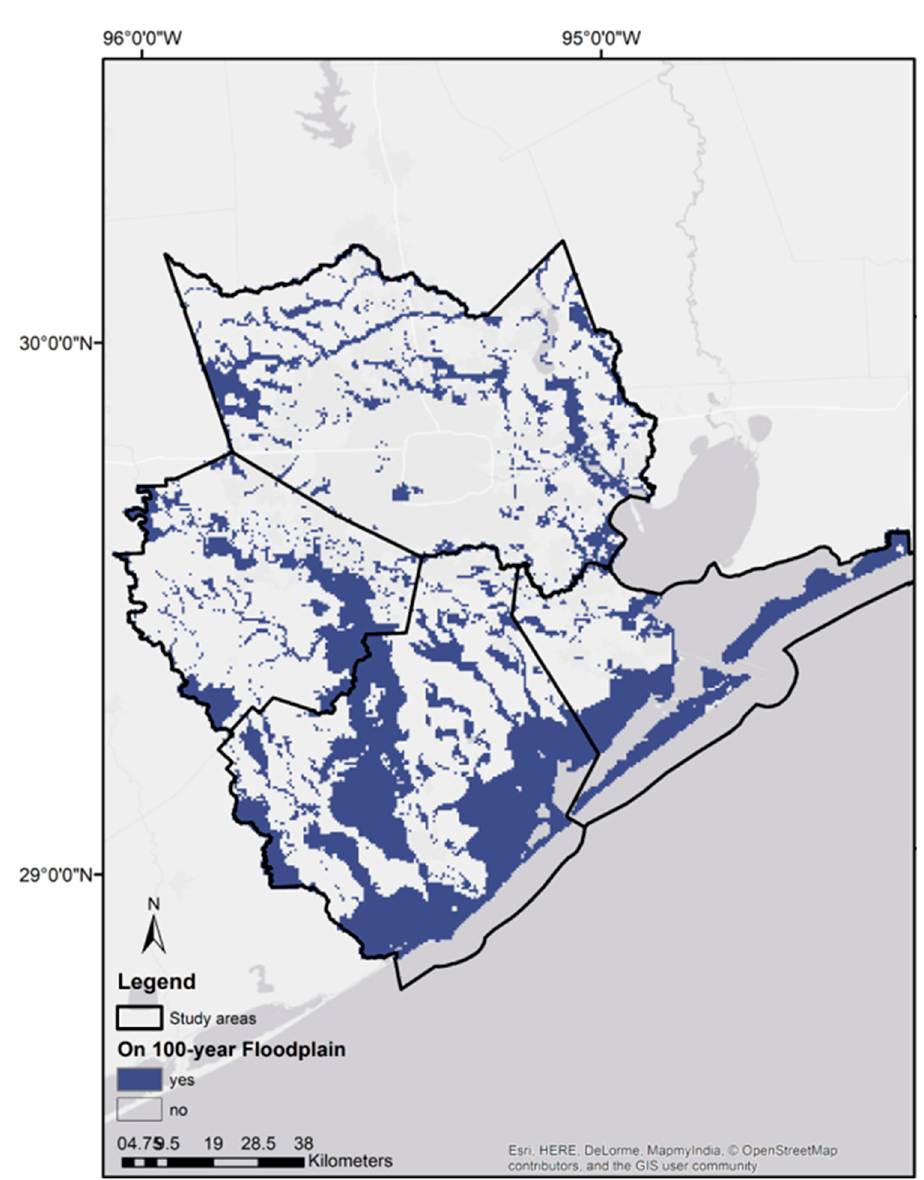
Figure A3. FEMA floodplain map showing areas has the potential of 100-year Figure A3 . FEMA floodplain map showing areas has the potential of 100-year floods